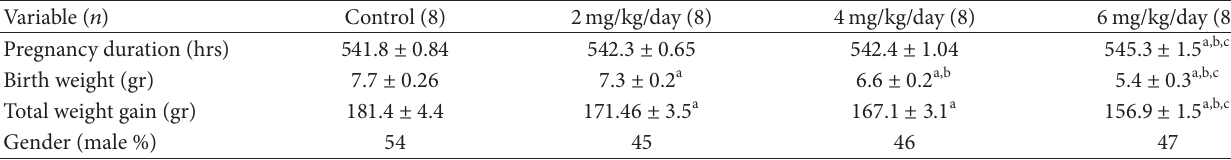
Table 1: General characteristics of rats and their newborns in 4 different